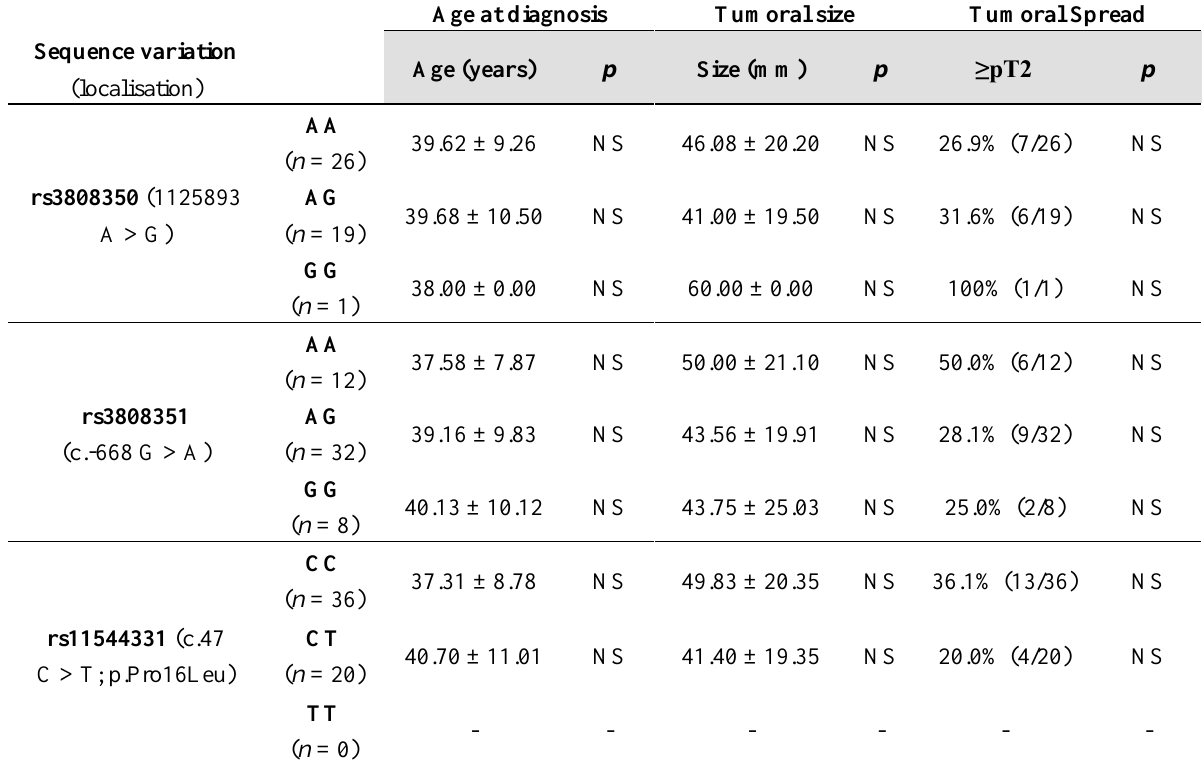
Table 2. Analysis of clinical data of the 56 genotyped patients with seminomas according to the GPER genotype. Data are expressed as mean ± standard deviation or as percentage; “ n ” is the total number of genotyped samples in each category. Comparisons were performed between each genotype for each SNP; a p value < 0.05 was considered statistically significant (NS: non